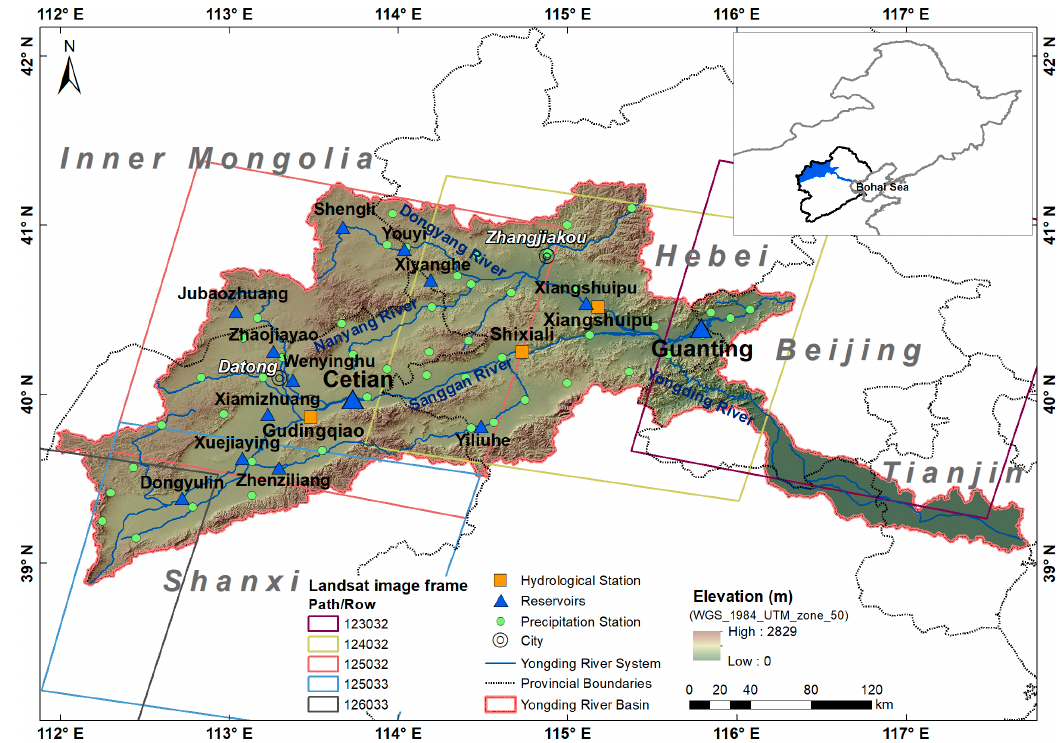
Figure 1. Location of the Yongding River Basin (YDRB) study area with elevation from Shuttle Radar Topography (SRTM) Mission Digital Elevation Model (DEM).